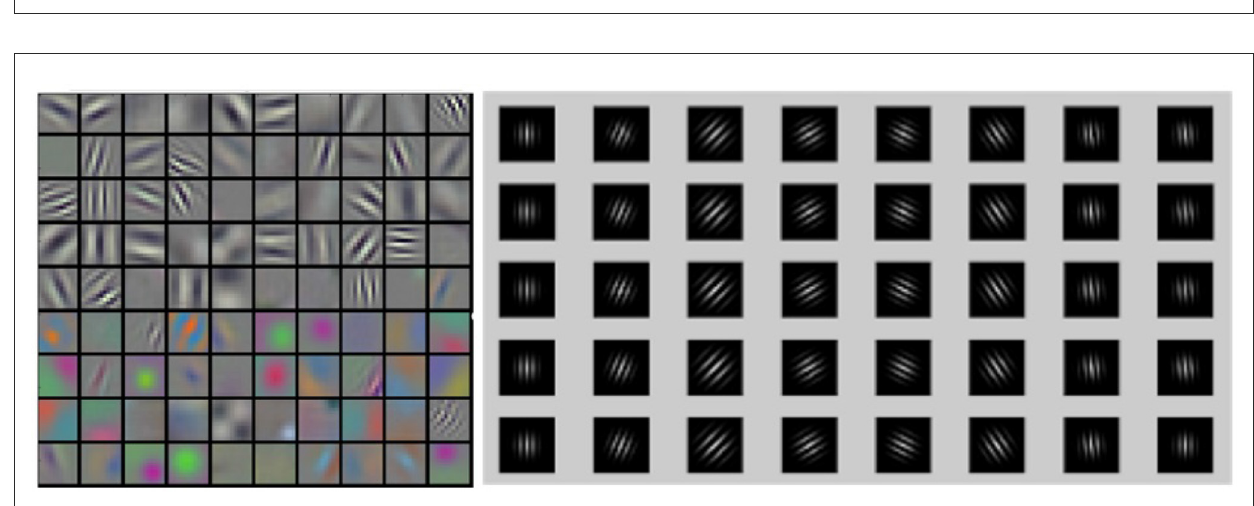
Structure Similarity Index Measure (SSIM) in the loss function.